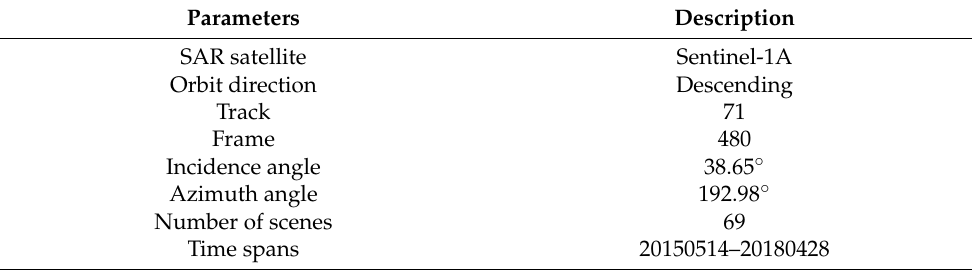
Table 1. Parameters of the SAR datasets used in the study.